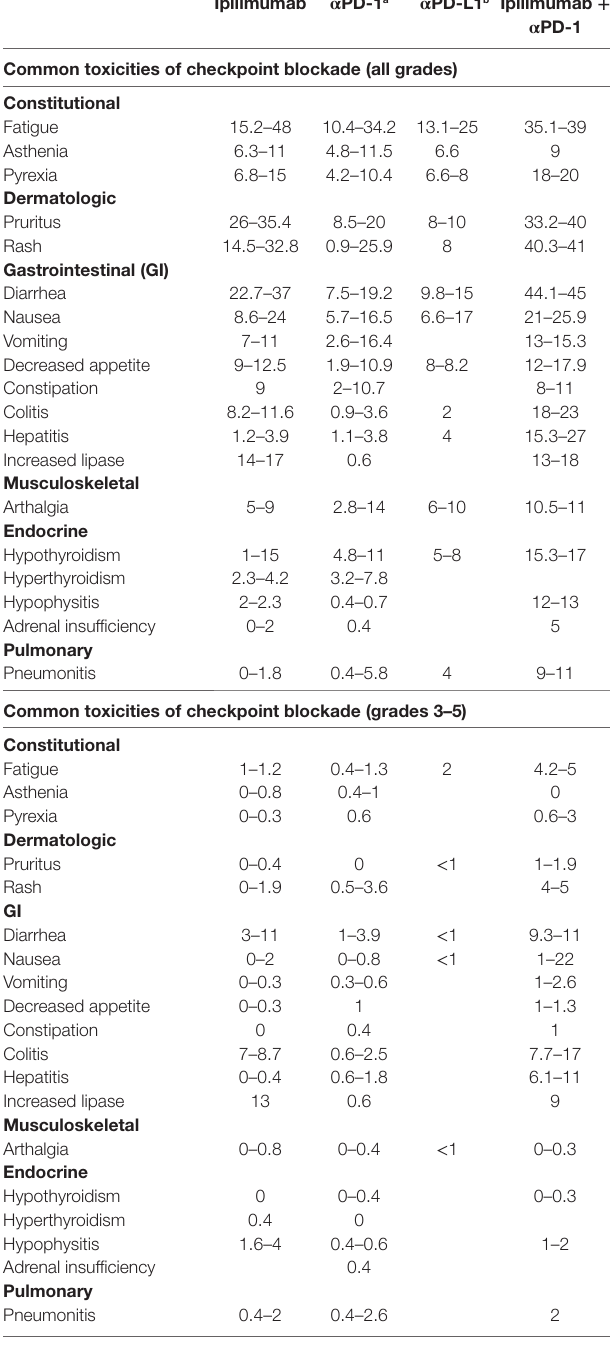
TaBle 1 | Frequency of common toxicities associated with checkpoint